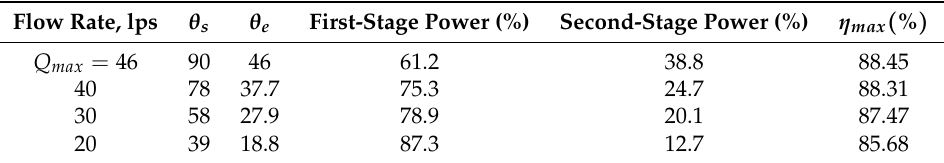
Figure 13. Contours of mean water velocity at part-flow operation at maximum efficiency [ Q = 20 lps, H = 1.337 m, ω = 199 RPM, and θ s = 39 ◦ ]. The end of the slider, labeled the “slider position” for Q max and Q = 20 lps is shown for both nozzles. Table 3. Design and performance calculations at